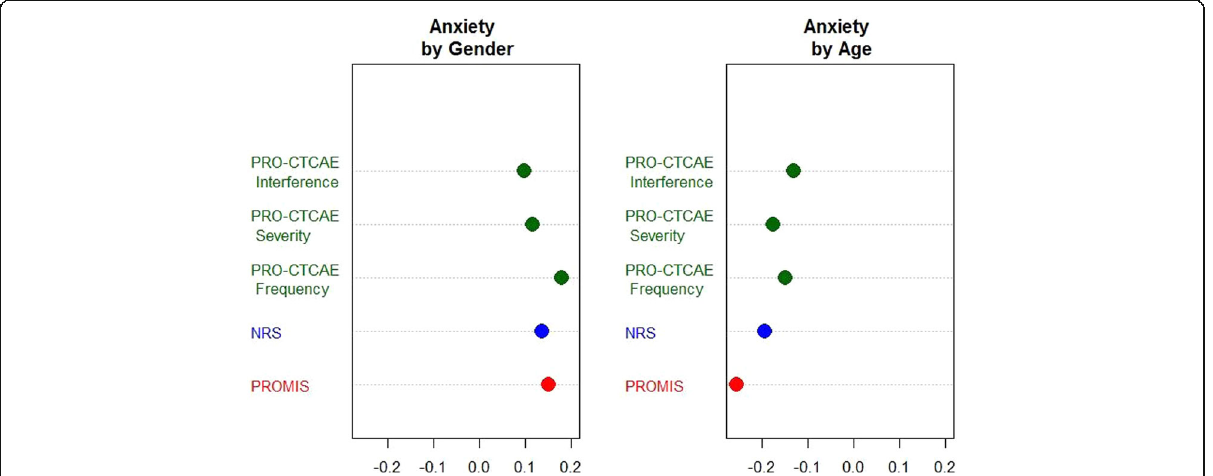
Fig. 1 Standardized Mean Differences by Gender and Age (< 60 vs ≥ 60). Average Female subtracted by male scores, and average older ( ≥ 60) subtracted by younger (< 60) scores are presented for anxiety scales